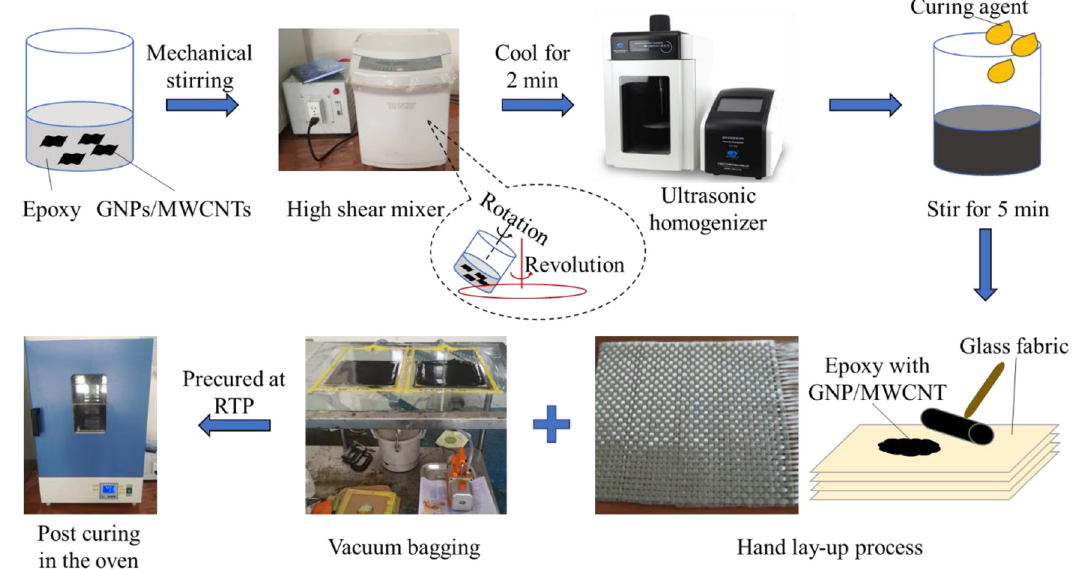
Figure 1: Preparation process of the GNP - glass and MWCNT - glass